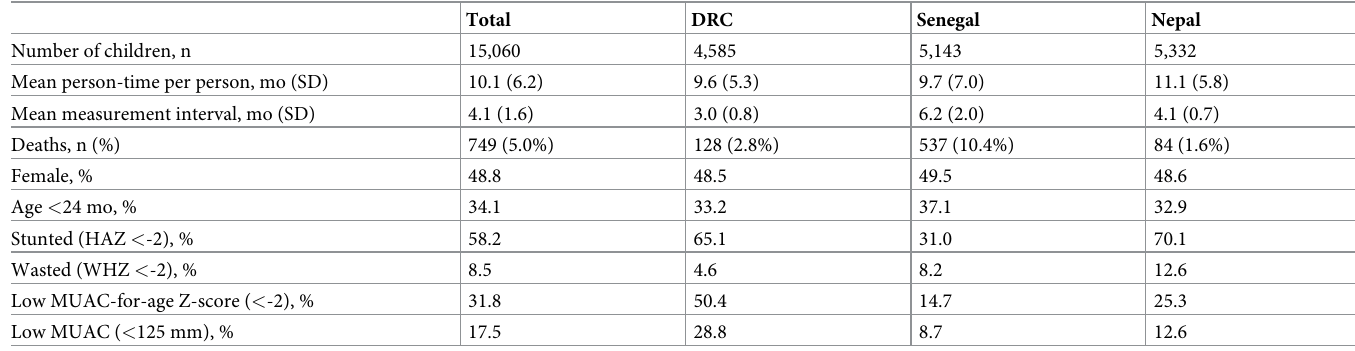
Table 2. Cohort characteristics and anthropometric status for all children aged 6–59 months in the pooled analysis and for each original study